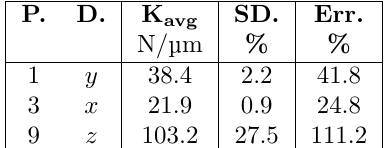
Fig. 16 for the test points in the